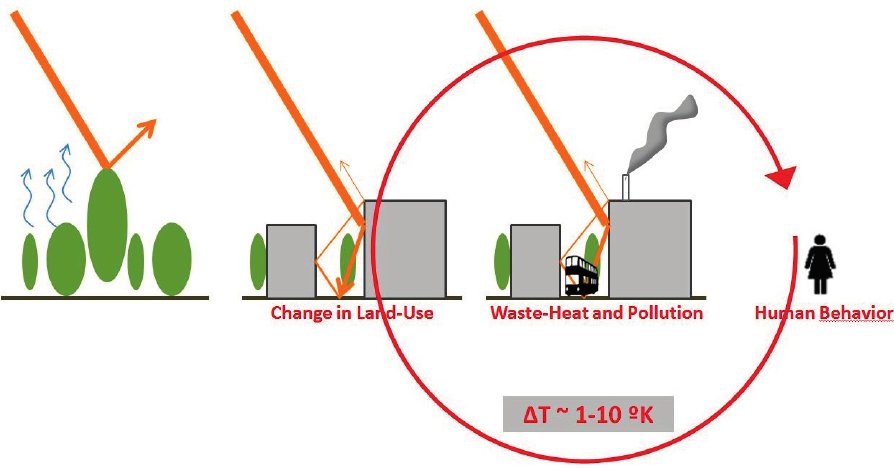
Figure 2. The negative loop and factors contributing to the deterioration of the street